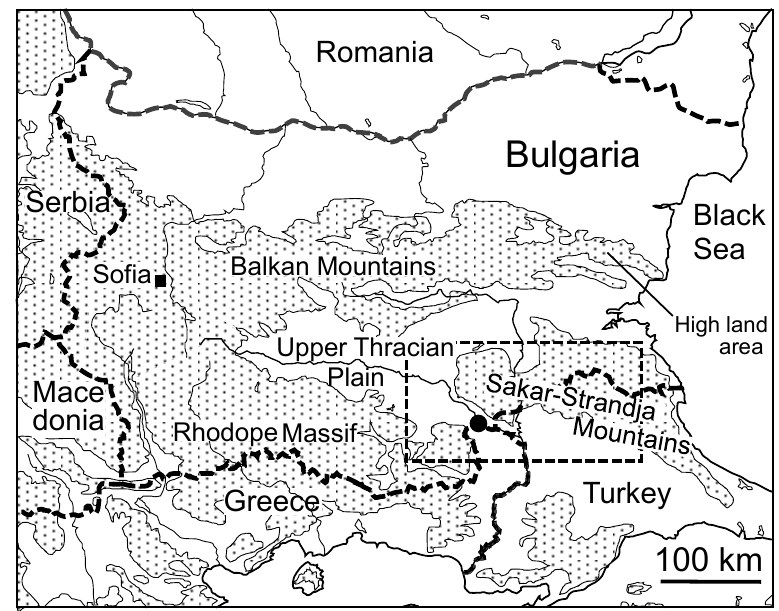
Figure 1. Location map of the Upper Thracian Plain and the Svilengrad–Brantiite site (solid circle) in Bulgaria; geological map of the area around the site (Figure 2) is shown as a dashed box.